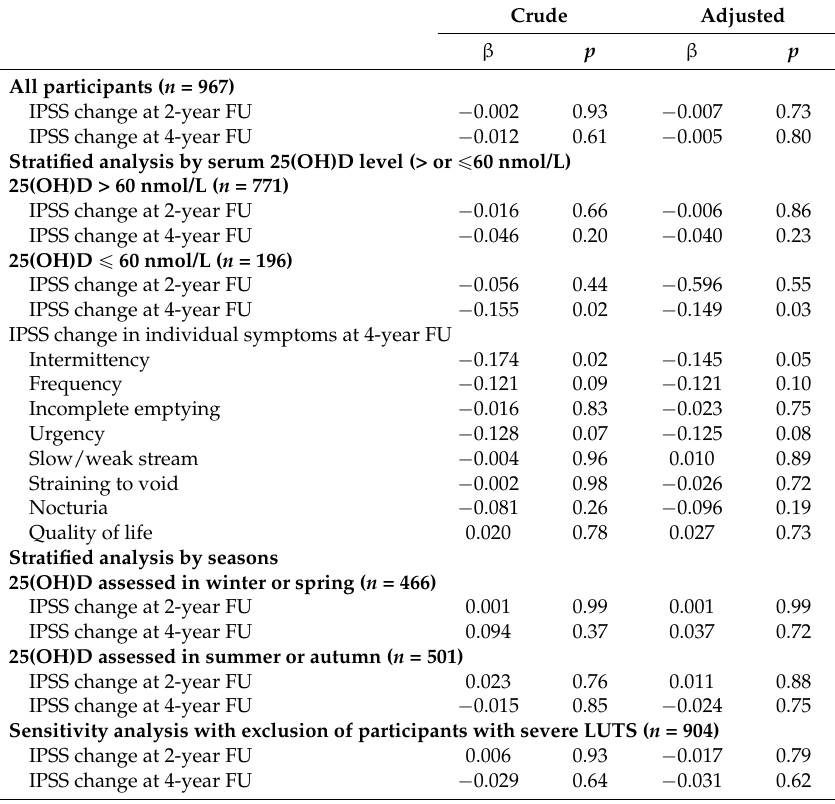
Table 3. Univariate and multivariate linear regression analyses on the association of serum 25(OH)D and the changes of International Prostate Symptom Score (IPPS) at two-year and four-year follow-ups as well as stratified analyses by different 25(OH)D levels, seasons and severity of LUTS. Crude